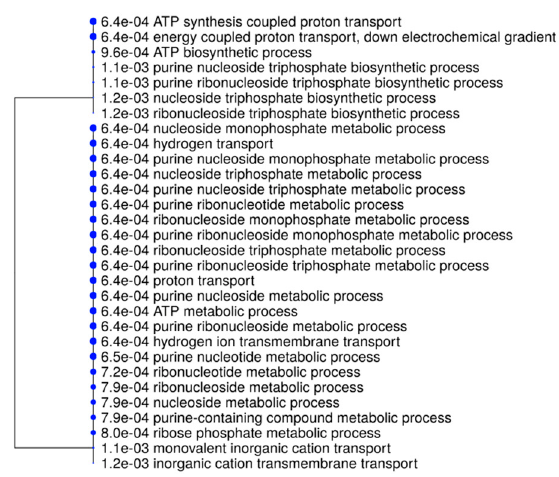
Figure 5. A hierarchical clustering tree. Pathways with many shared genes are clustered together. Larger dots indicate more significant p -values.